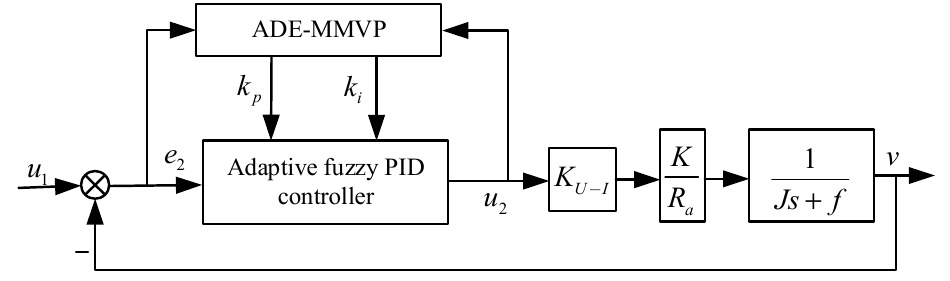
Figure 6. Structure of speed loop control system.